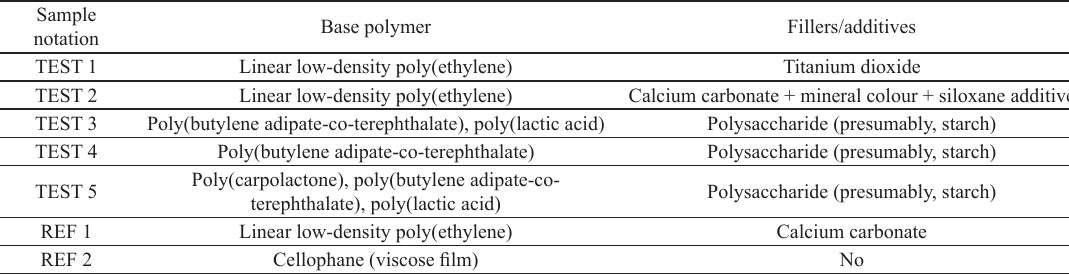
Table 2. The assumed composition of the bags’ samples according to the FTIR and DSC